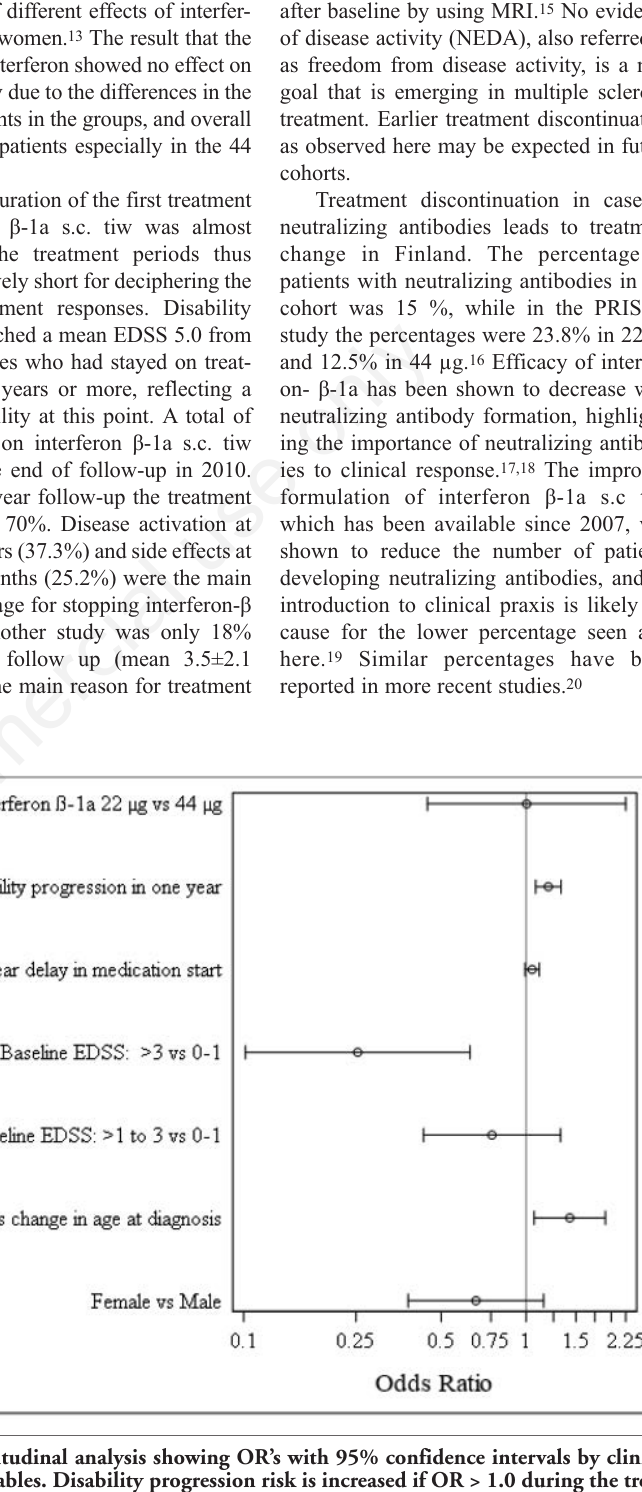
Figure 2. The mean EDSS points at mild disability (3.0 or less) during the first 3 years of treatment.